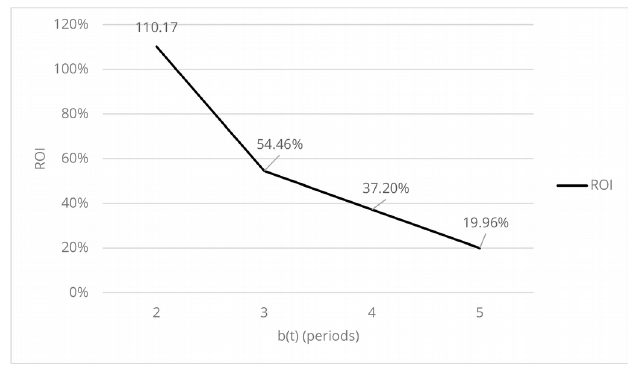
Figure 4. Effects of interruption time to The ROI